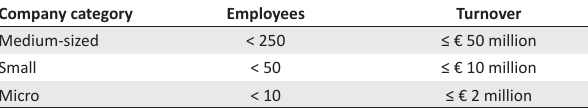
TABLE 2: Factors determining small and medium enterprises status. Company category